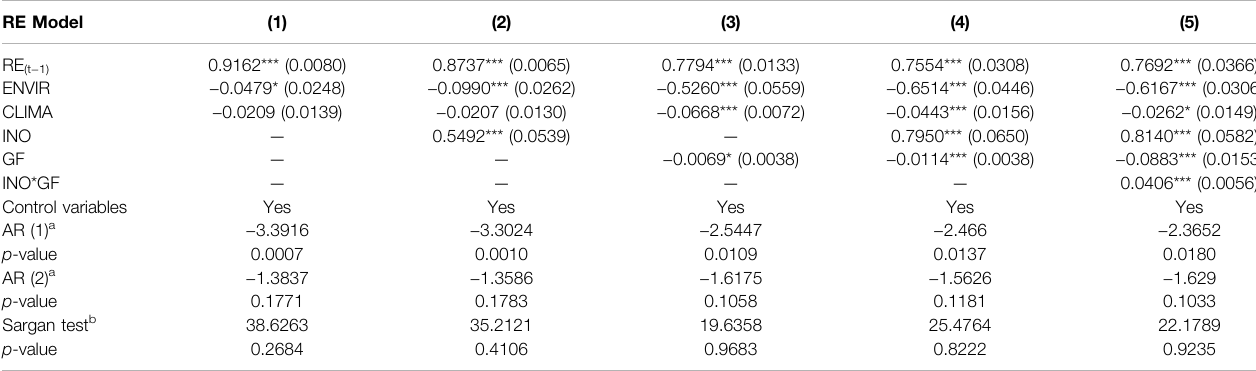
TABLE 4 | Energy consumption